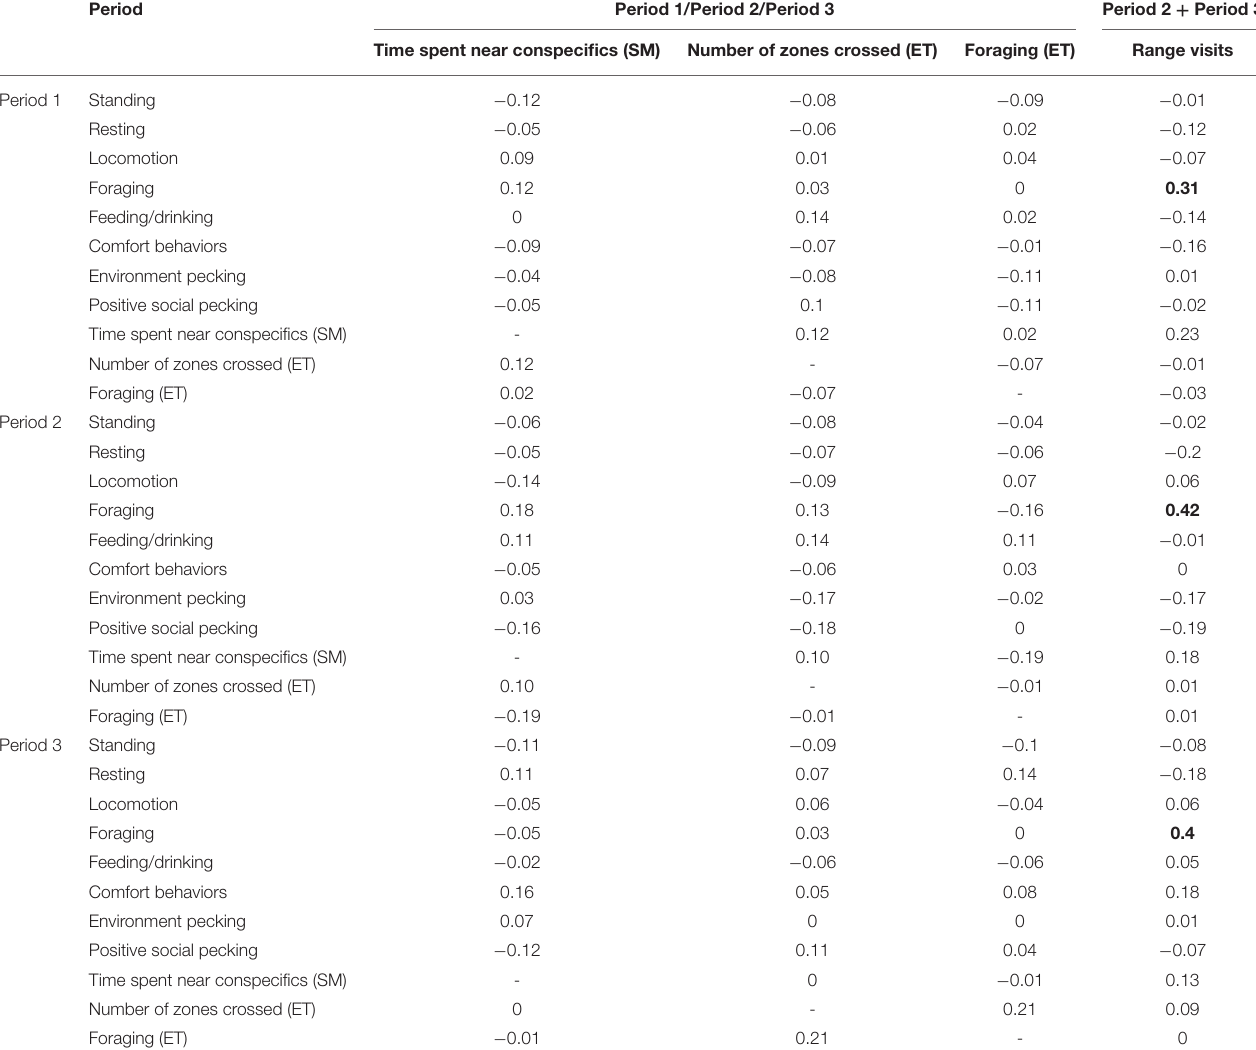
TABLE 3 | Rank correlations between behaviors of male broiler free-range chickens in their home environment and in the individual tests (social motivation, SM, and exploration tests, ET), over different periods. Period Period 1/Period 2/Period